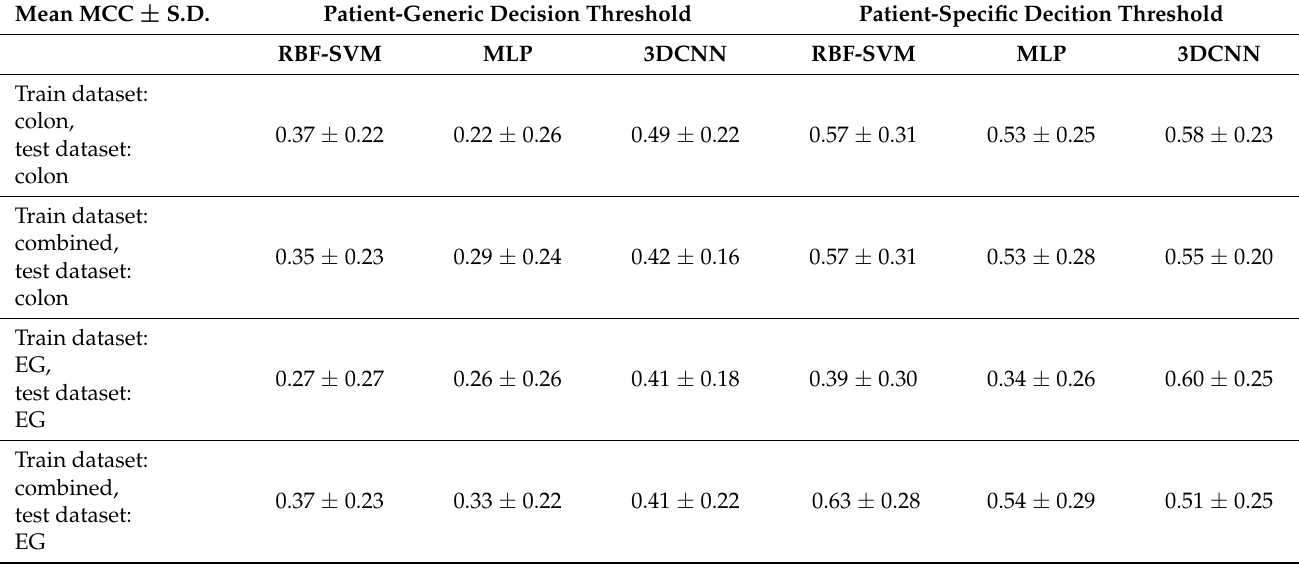
Table 6. Matthews correlation coefficient (MCC) performance of different models evaluated on the colon and esophagogastric (EG) datasets. Mean MCC ± S.D.